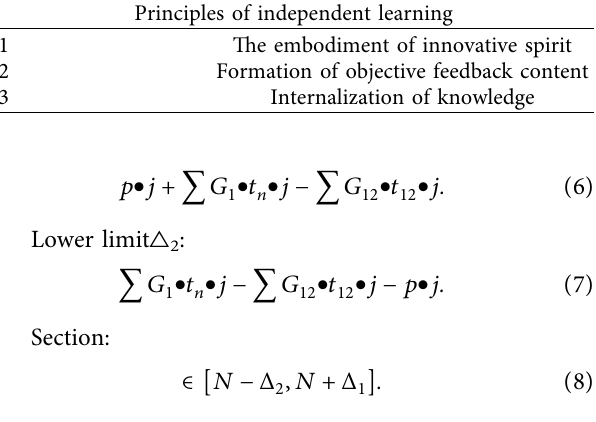
Table 4: Principles of independent